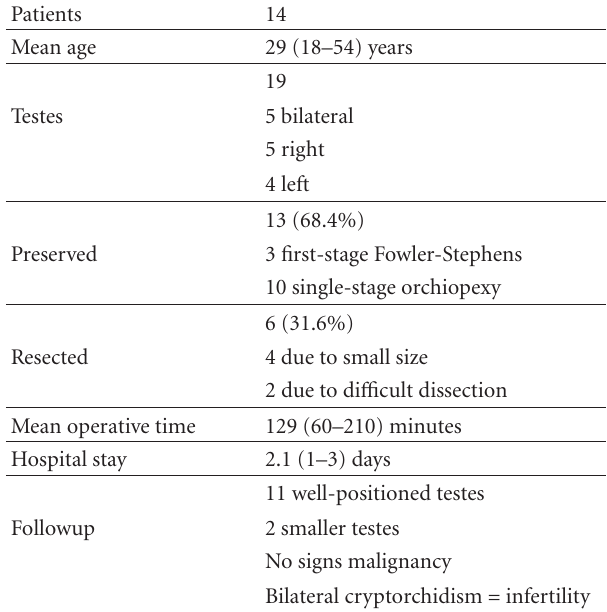
Table 1: Demographic data and intra- and postoperative outcomes.